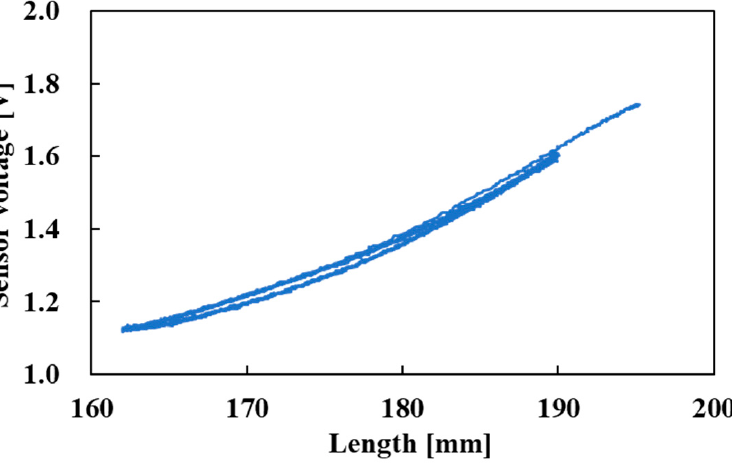
Figure 17. Relationship between length and sensor voltage (pneumatic pressure: 0.0 MPa → 0.3 MPa → 0.0 MPa, five times).